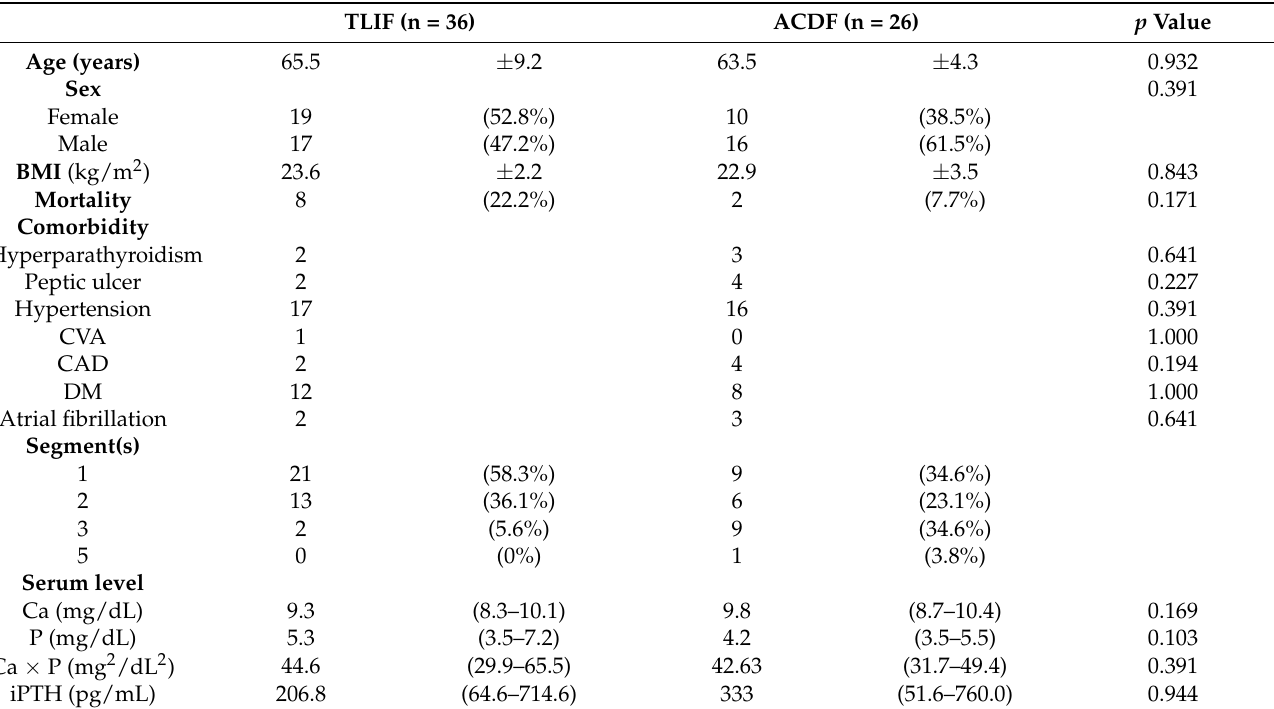
Table 1. Demographic data and serum levels of the study population stratified by interbody fusion